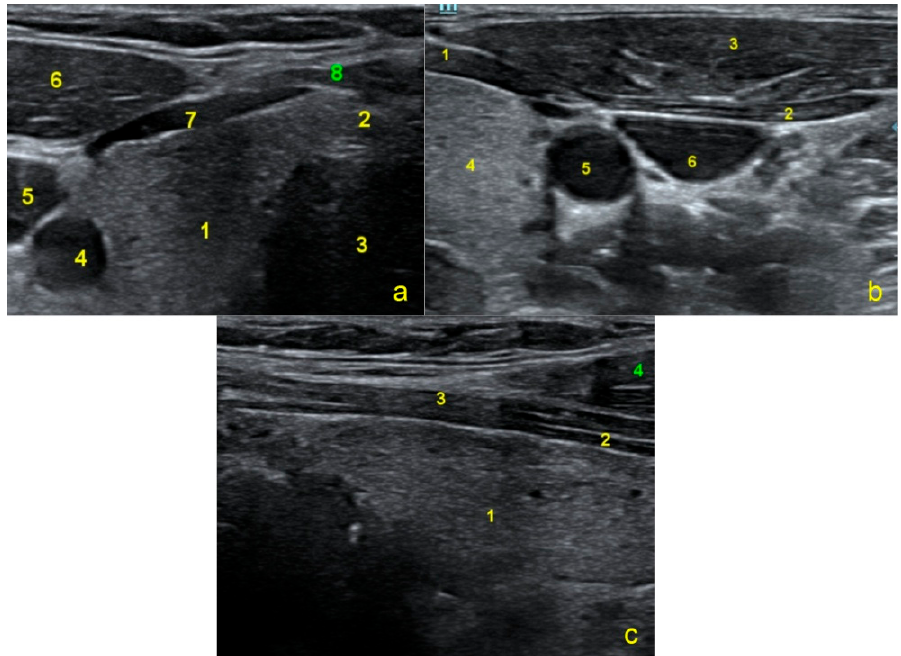
Figure 7. ( a ) Axial view at the level of the thyroid: Right thyroid lobe (1), isthmus (2), trachea (3), common carotid artery (4), internal jugular vein (5), sternocleidomastoid (6), sternothyroid (7), and sternohyoid (8). ( b ) Axial view showing the sternothyroid (1), omohyoid (2), sternocleidomastoid (3), thyroid (4), common carotid artery (5), and internal jugular vein (6). ( c ) Longitudinal view at the level of the thyroid shows the right thyroid lobe (1), sternothyroid (2), sternohyoid (3), and sternocleidomastoid (4).